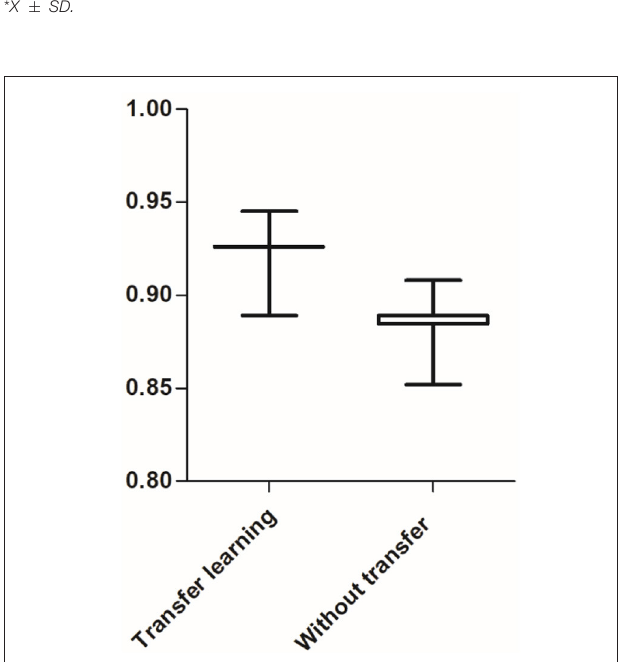
FIGURE 12 | Boxplot of fault diagnosis accuracy of the different methods.